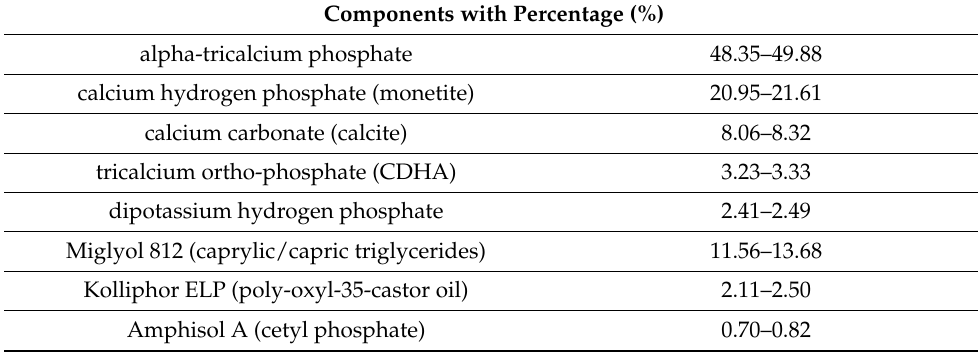
Table 1. Composition of INNOTERE Paste-CPC.